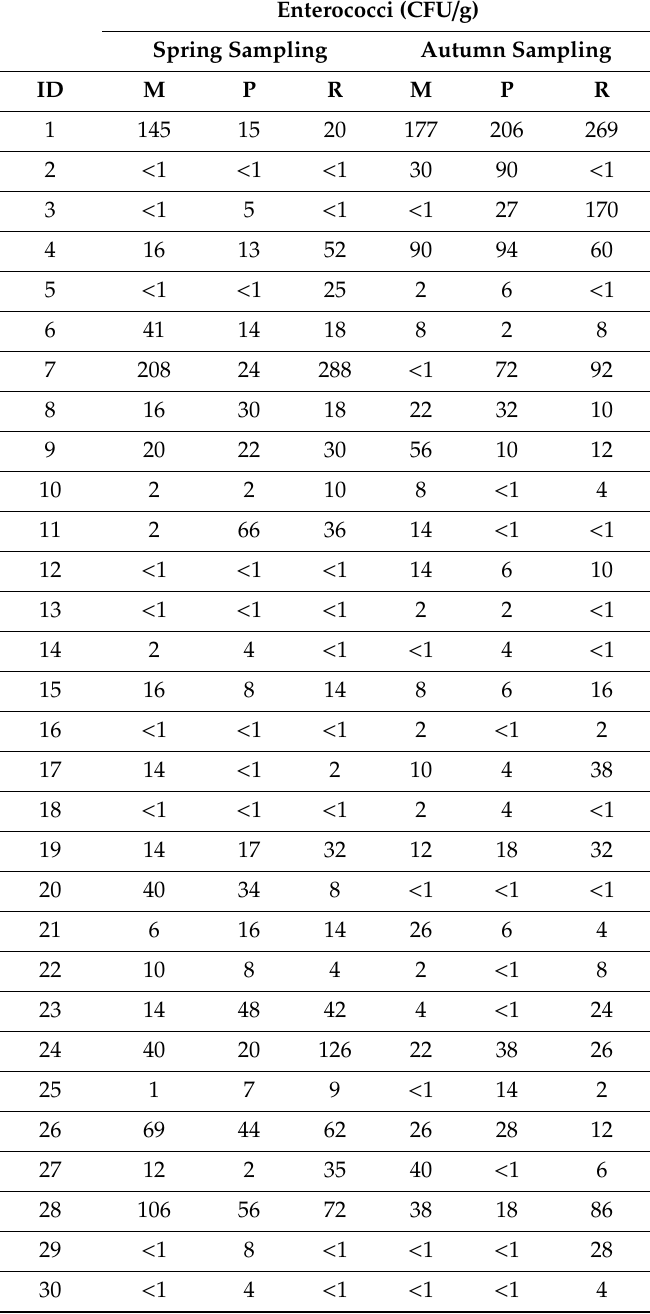
Table 5. Enterococci. Microbial counts are reported for the enterococci indicator parameter. M—maturing mud, P—peloid, R—regenerating used